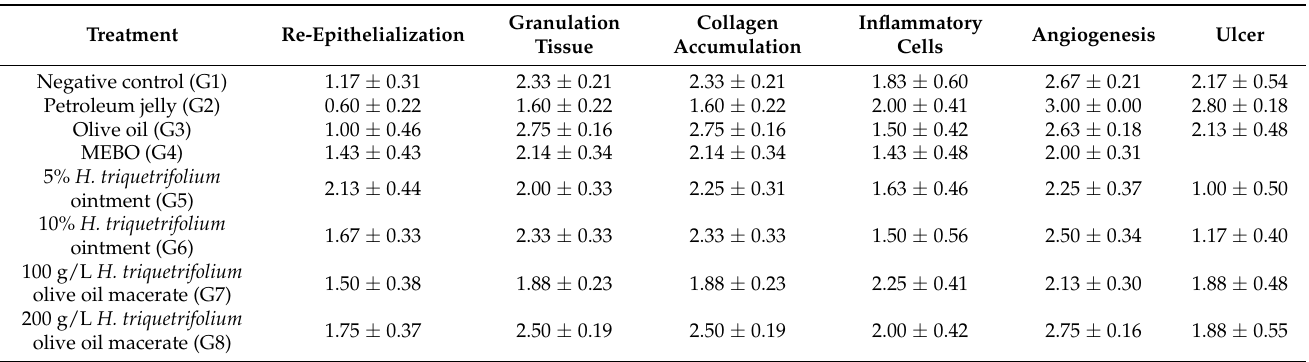
Table 2. Histopathological evaluation of wound healing processes and phases treated with different investigated